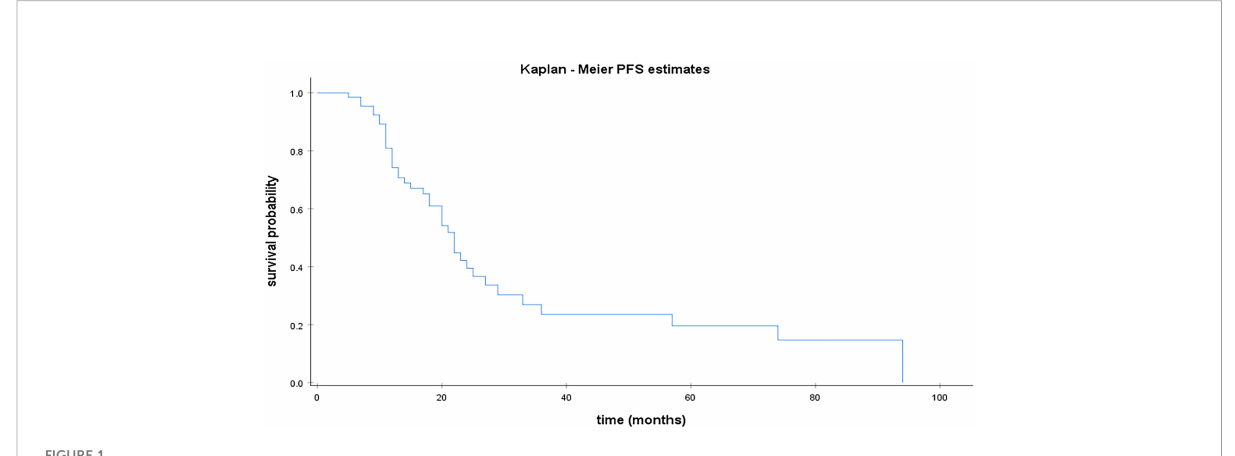
FIGURE 1 Kaplan Meier curve for PFS in